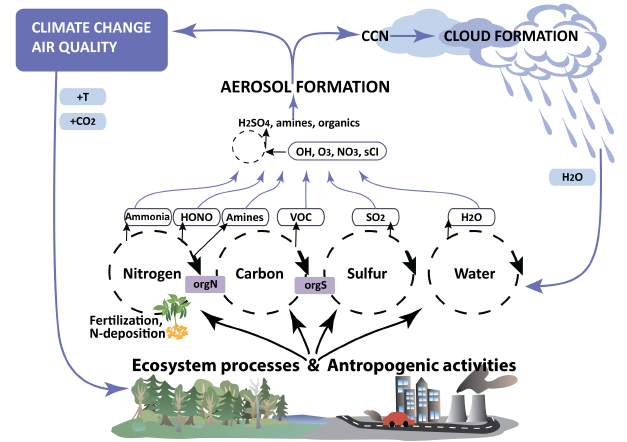
Figure 5. Hydrological cycle